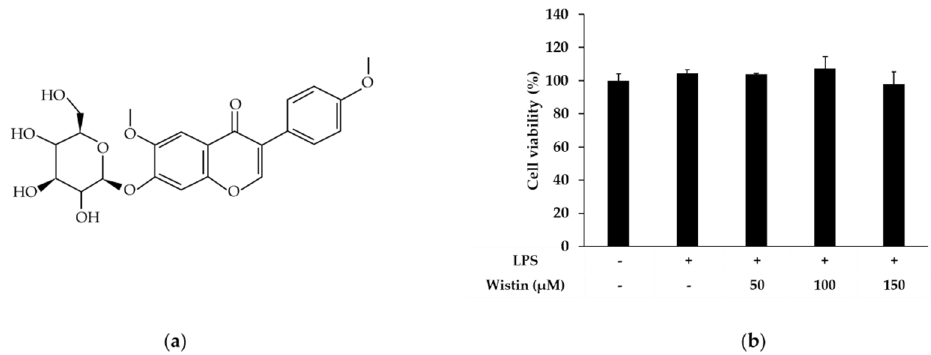
Figure 1. The effects of wistin on cell viability in LPS-induced RAW 264.7. ( a ) The chemical structure of wistin. ( b ) The cells were treated with the indicated concentrations of wistin (0, 50, 100, 150 µ M) for 30 min prior to treatment with LPS (0.1 µ g/mL) for 24 h, and then cell viability was examined using MTT assay. The data are presented as the means ± SD; n = 3.